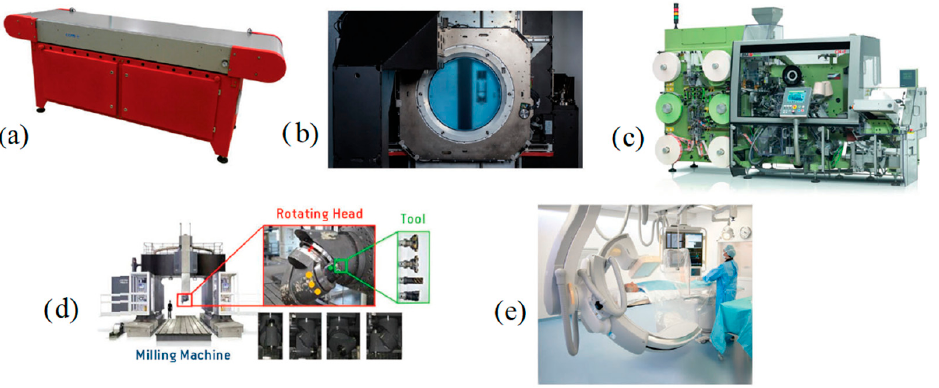
Figure 7. List of application areas where developed building blocks and platform were validated